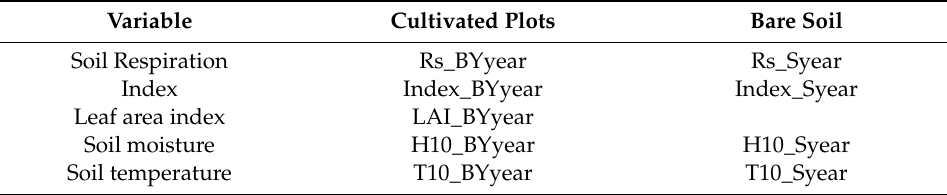
Table 3. Names of the variables used in the